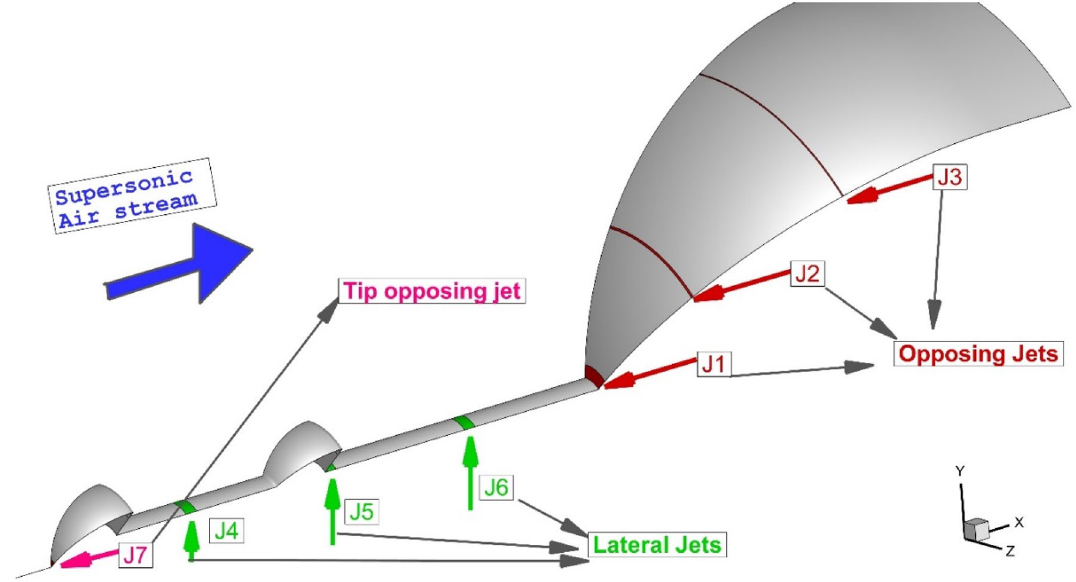
Figure 2. Injection system for cooling of the nose cone with double aerodisked spike.